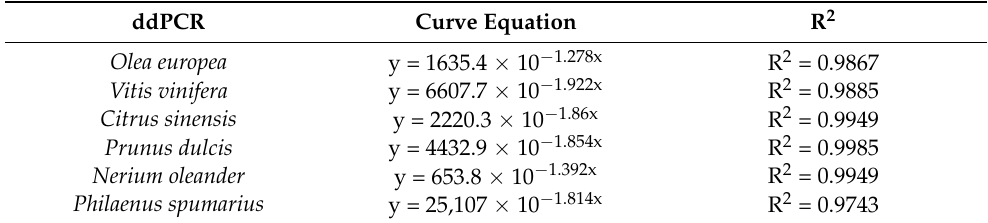
Table 1. Equation of regression curves and R 2 values generated by ddPCR for the six matrices spiked with Xfp bacterial suspension.